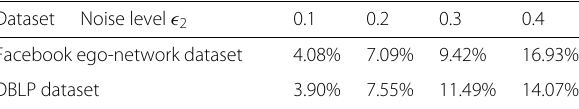
Table 3 Relative enhancement of the proposed noise-aware game-theoretic algorithm over the AGM on real-world